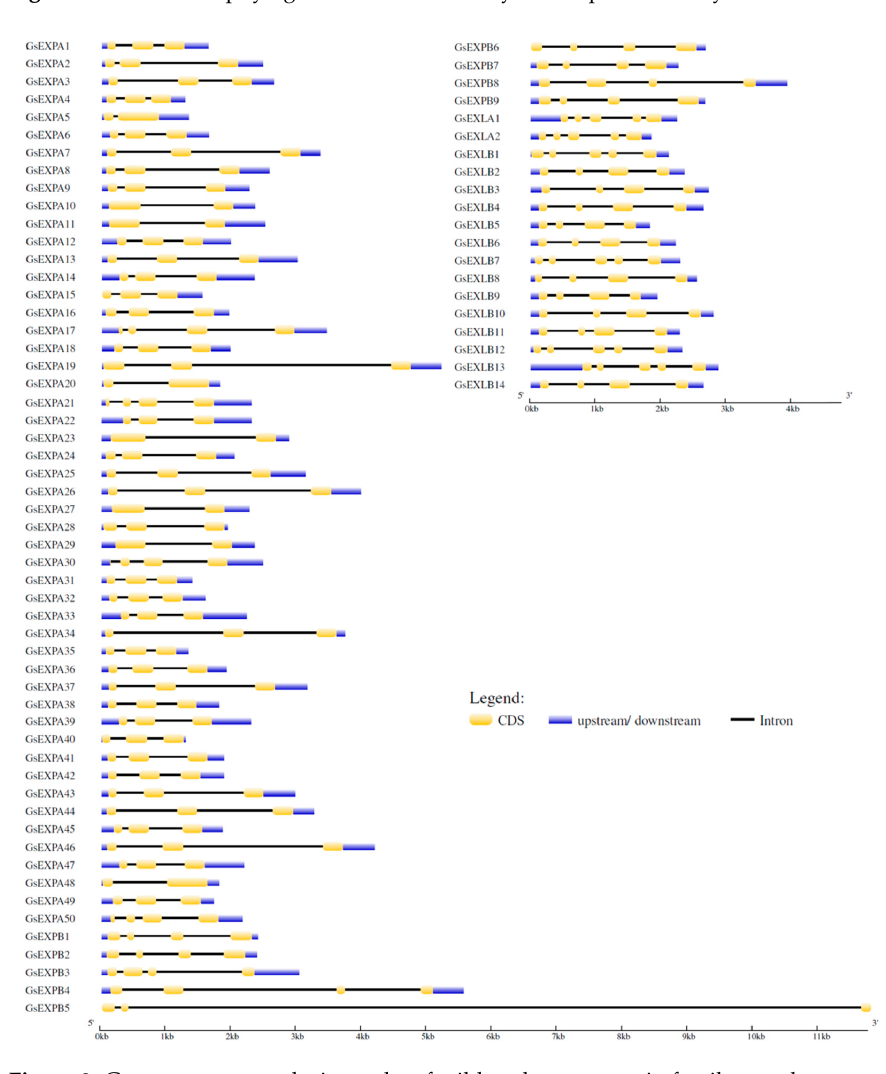
Figure 2. Gene structure analysis results of wild soybean expansin family members.